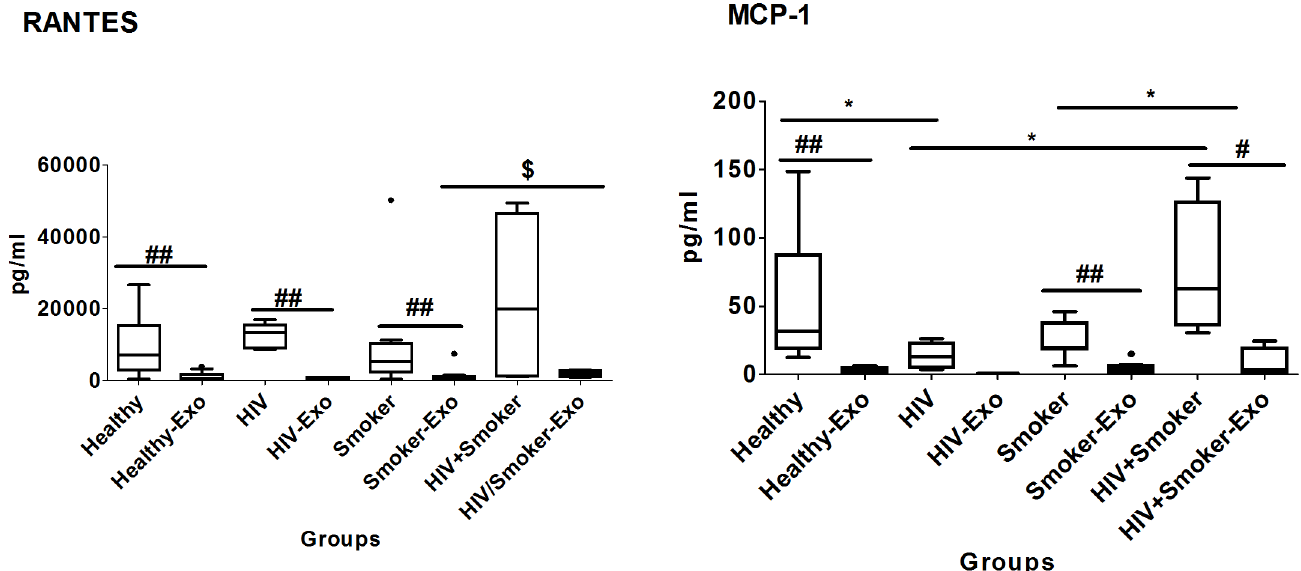
Fig 6. Box and whisker plots of chemokines between HIV-negative non-drug abusers (healthy), HIV-positive non-drug abusers (HIV), HIV-negative smokers (smokers) and HIV-positive smokers (HIV+smoker). For comparison with other study groups, the bar graphs for healthy and HIV subjects were replicated from Fig 3.The box represents the 25 th -75 th quartile, the whiskers represent the range of values, the median is presented as a line inside the box, and the out-of-range values are presented as circles. The Mann–Whitney U test was used to compare between plasma and exosomes of different study groups as well as and significant p-values are represented as # (p (cid:20) 0.05) and ## (p (cid:20) 0.01Comparison of cytokine levels among plasma as well as exosomes of different groups were done using Mann–Whitney U test and significant p-values are given as (cid:3) (p (cid:20) 0.05), (cid:3)(cid:3) (p (cid:20) 0.01) and $ (p (cid:20) 0.05), $$ (p (cid:20) 0.01), respectively.